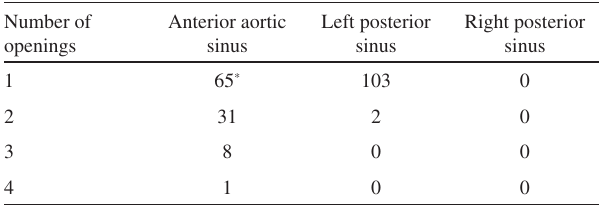
Table 1 - Number of cases of single/multiple ostia in the aortic sinuses